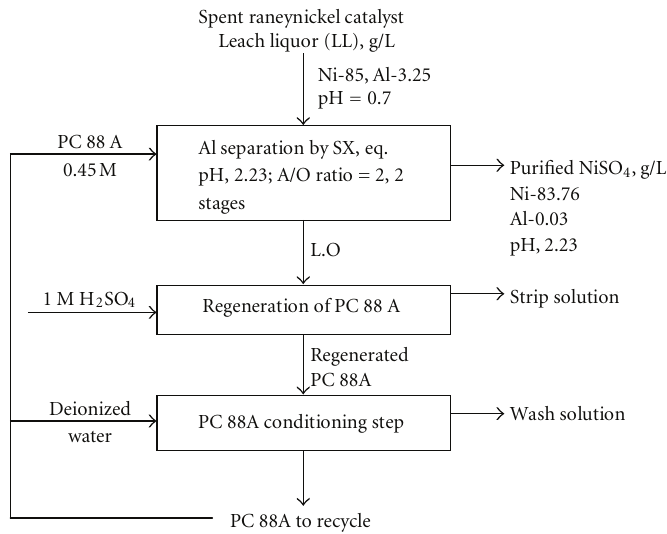
Figure 4: Regeneration and reuse of PC 88 A. Table 2: E ff ect of phase ratio on Al stripping from loaded organic (L.O). Al in L.O = 6.47 g/L H 2 SO 4 ; 1 M, time: 15 min. Extractant Phase ratio (O:A) Al stripping e ffi ciency (%) Theoretical number of stages to get > 99% e ffi ciency